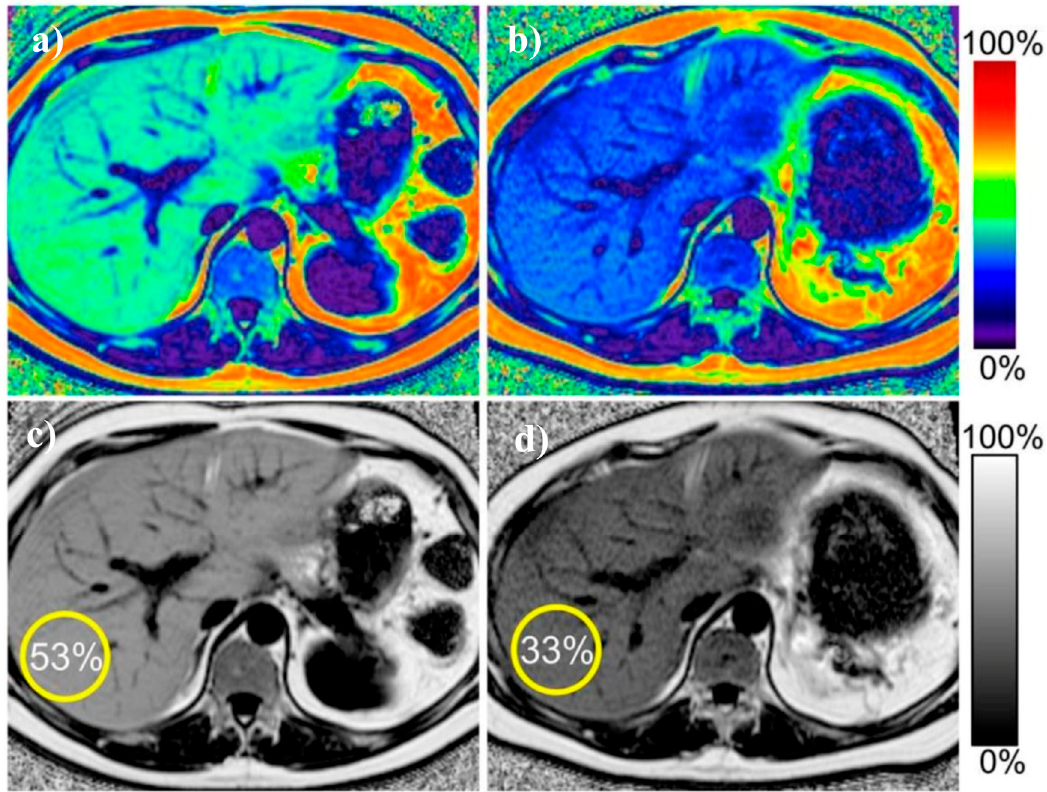
Figure 3. Example of proton density fat fraction liver maps in the same patient before and after treatment. Improvement in the liver steatosis and reduction in liver size is visible. ( a ) pre-treatment color-scale map ( b ) post-treatment color-scale map ( c ) pretreatment gray-scale map ( d ) post-treatment grey-scale map. Figure from Reeder SB, et al. Quantitative Assessment of Liver Fat with Magnetic Resonance Imaging and Spectroscopy. J. Magn. Reson. Imaging 2011 , 34 , 729–749